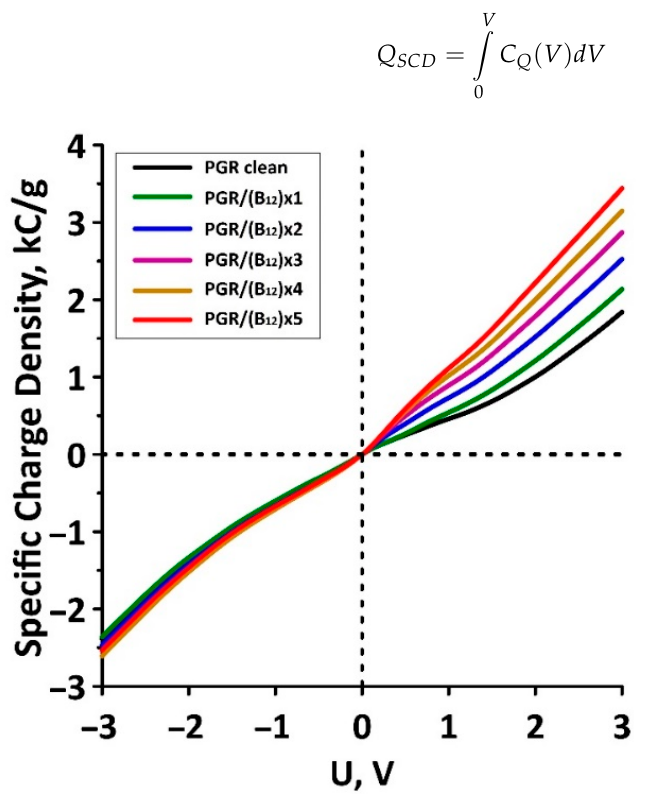
Figure 4. Q SCD for the pure PGR and for the PGR decorated with 1 to 5 boron clusters. The look of the curves in Figure 4 indicates the symmetrical behavior of the material with an increase in number of B 12 clusters up to two. However, with further clusters up to five, the picture slightly changed, and the asymmetry of the negative and positive branches appeared. In the negative branch, the curves were almost constant, and this was directly related to the values of C Q in the voltage range from − 3 to 0 V. Here, the change in C Q was not so pronounced. Specific charge density indicates how much charge, in terms of mass, the electrode material can store. The increase in charge capacity is explained as a direct result of the additional availability of states near the Fermi level in DOS. From the nature of the Q SCD distribution, it follows that by changing the boron concentration, this electrode material can be used both in hybrid SCs and in symmetric